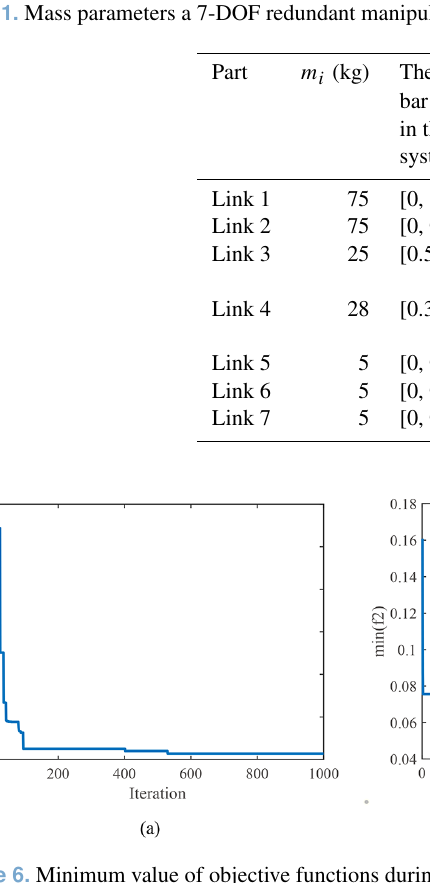
Figure 6. Minimum value of objective functions during iteration. (a) Angular velocity. (b) Joint jerk. (c) Energy.